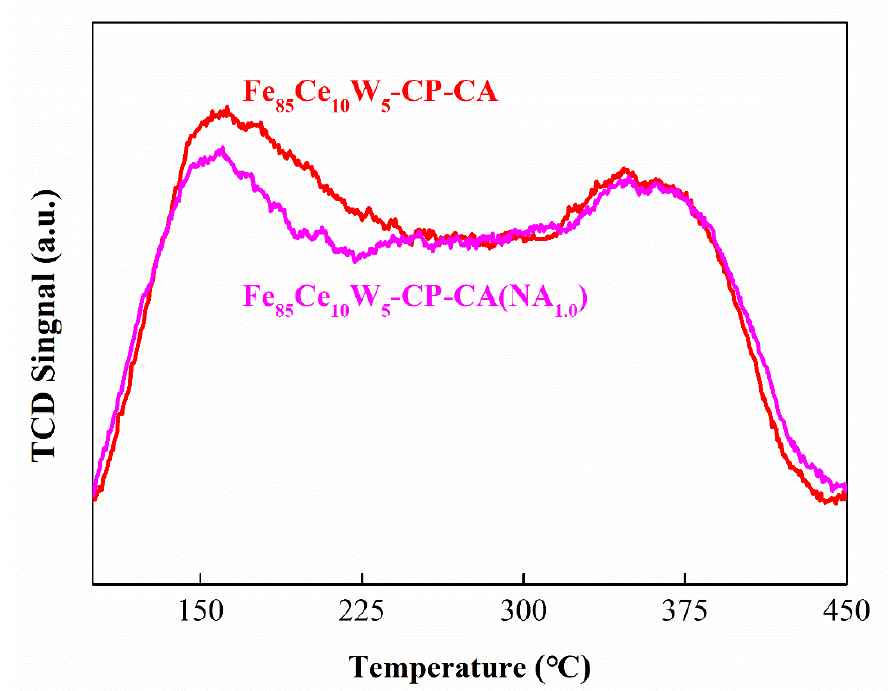
Figure 7. NH 3 –temperature programmed desorption (NH 3 -TPD) profiles of the catalysts.